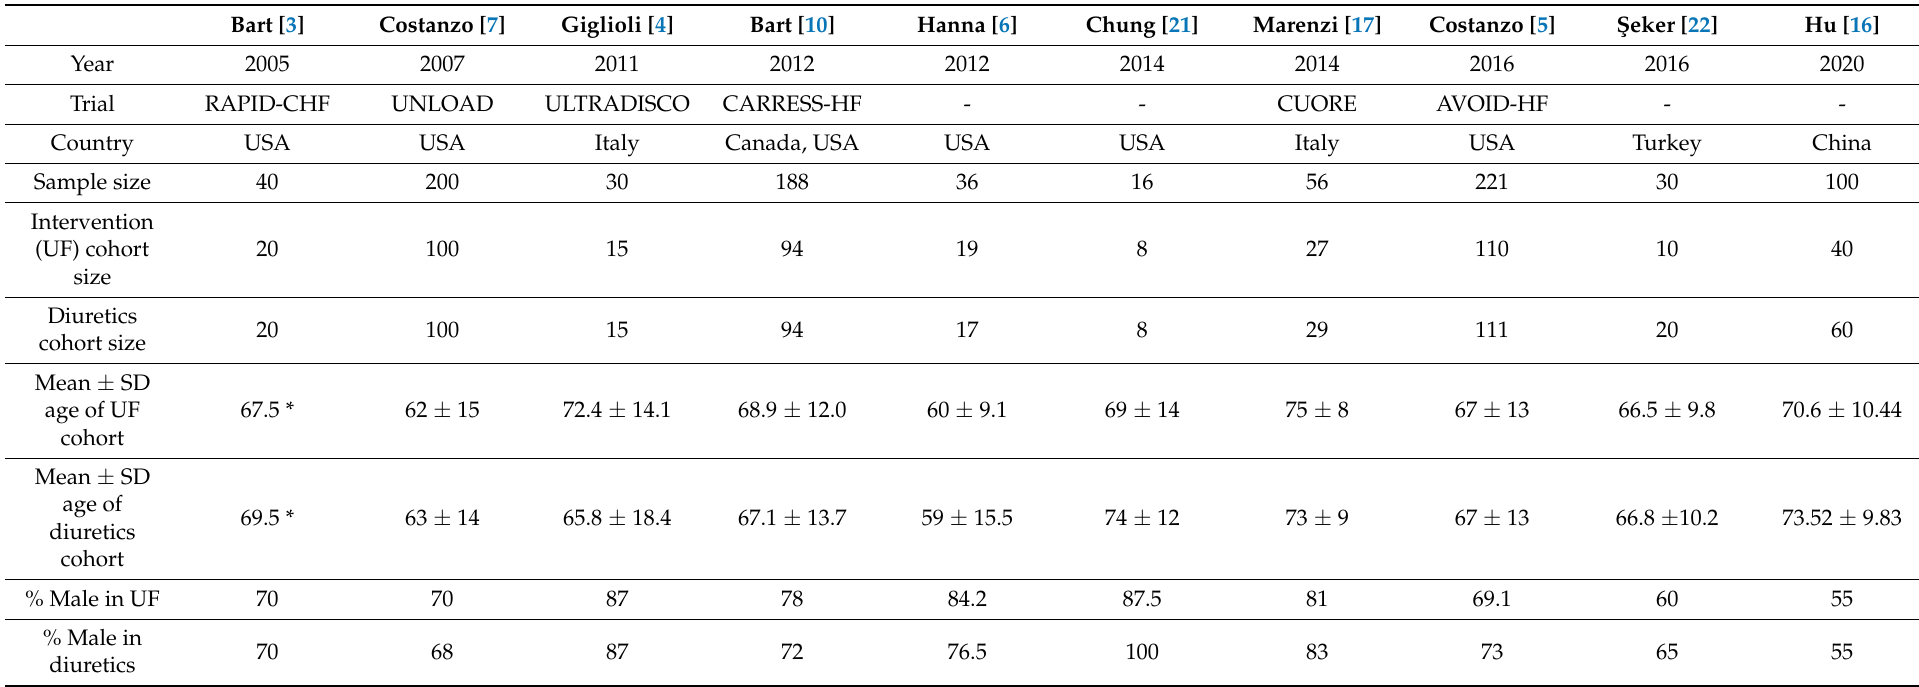
Table 1. Characteristics of population and study type for included studies.